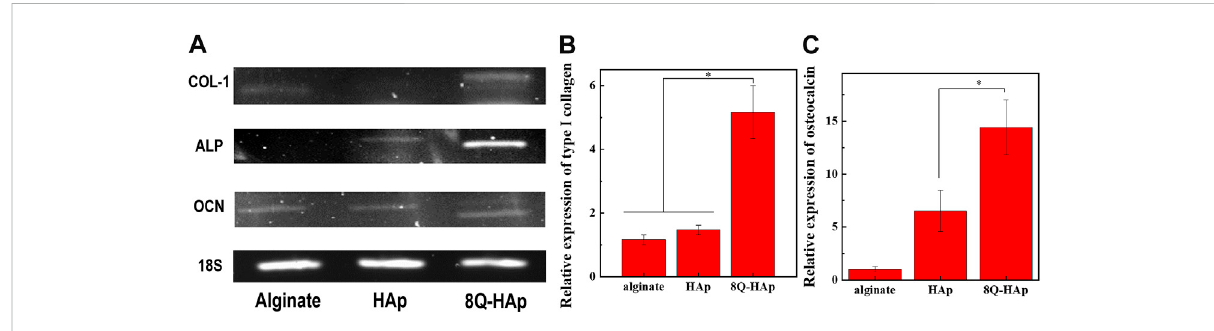
FIGURE 8 Osteogenicmarkergeneexpressionatweek3. (A) RT-PCRanalysisoftheexpressionofanosteogenicspeci fi cgeneand (B – C) qRT-PCRresults for genes monitored in each group (n = 3), * p < 0.05: COL-1 (B) and osteocalcin (C)